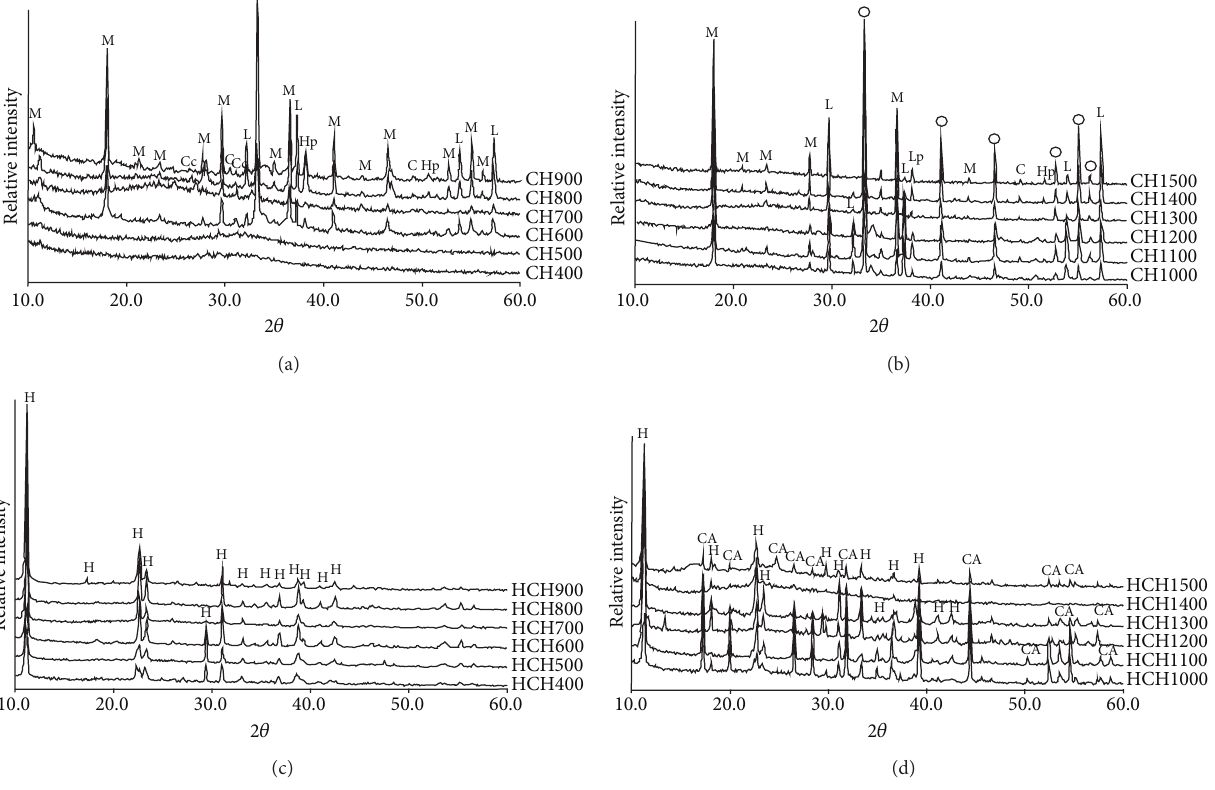
Figure 1: XRD patterns of hydrocalumite samples calcined over a temperature range of 400–1500 ∘ C and their rehydrated products. (a) Hydrocalumite samples calcined at temperatures ranging from 400 to 900 ∘ C; (b) hydrocalumite samples calcined at temperatures ranging from 1000 to 1500 ∘ C; (c) rehydrated samples corresponding to those in Figure 1(a); (d) rehydrated samples corresponding to those in Figure 1(b). C: calcite; CA: tricalcium aluminate hexahydrate; Cc: calcium chloride hydroxide; H: hydrocalumite; Hp: hydrophilite; L: